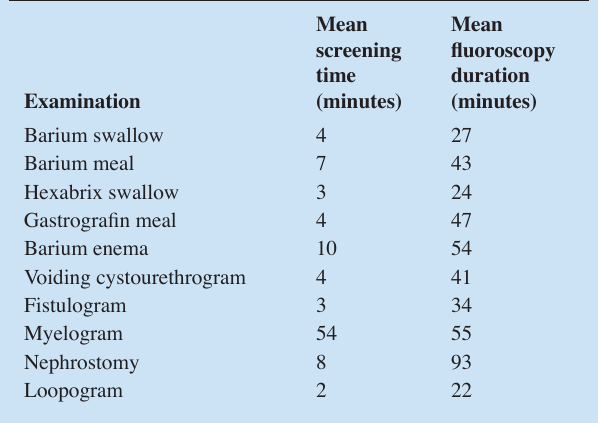
Table II. Mean screening time and mean procedure duration per examination